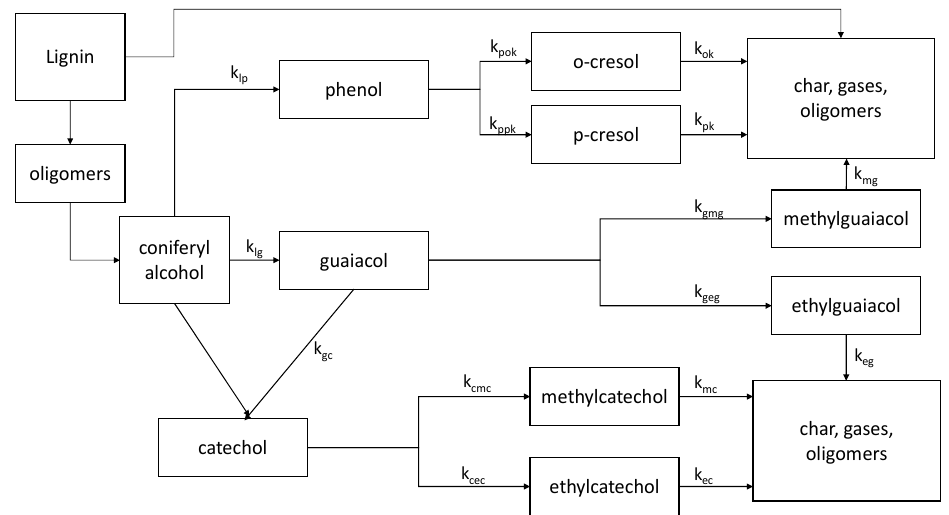
Figure 13. Reaction pathway for the degradation of Indulin AT. Figure is adapted from Schuler [140].